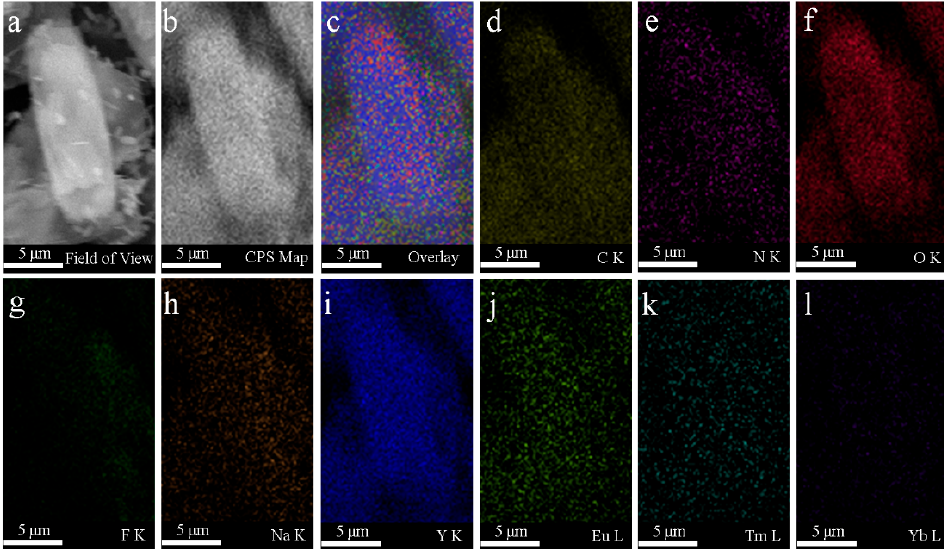
Figure 3. ( a ) SEM image of the NYFT@MOFY-1 sample. ( b – l ) SEM element mapping of the corresponding NYFT@MOFY-1 composites, C, N, O, F, Na, Y, Eu, Tm, and Yb, respectively.